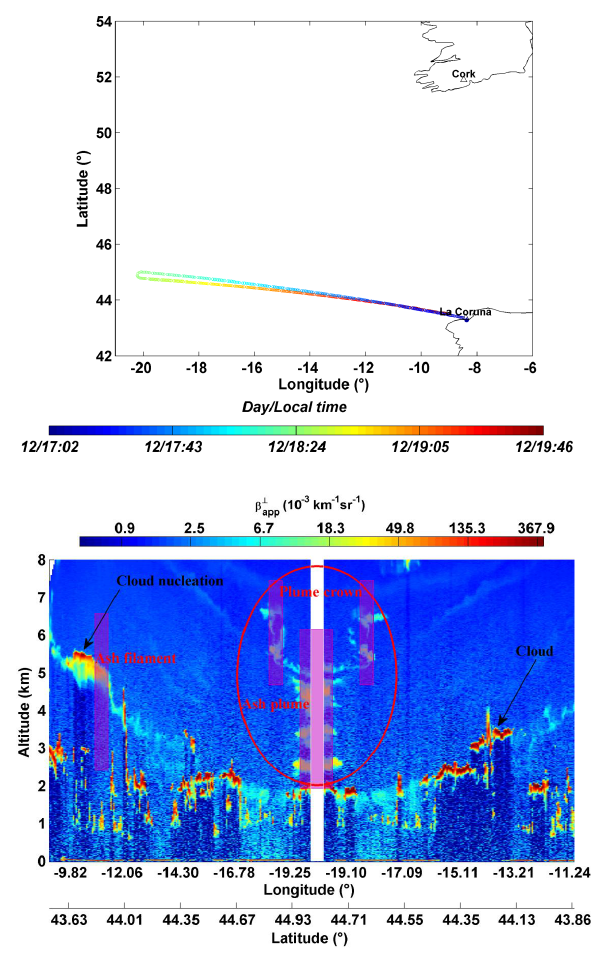
Figure 4: The same as Figure 3 for 12 May 2010, off La Coruna. The areas where the mean 588 Fig. 4. The same as Fig. 3 for 12 May 2010, off La Coruna. The ar- lidar profiles have been studied are highlighted by purple rectangles. 589 eas where the mean lidar profiles have been studied are highlighted by purple rectangles.